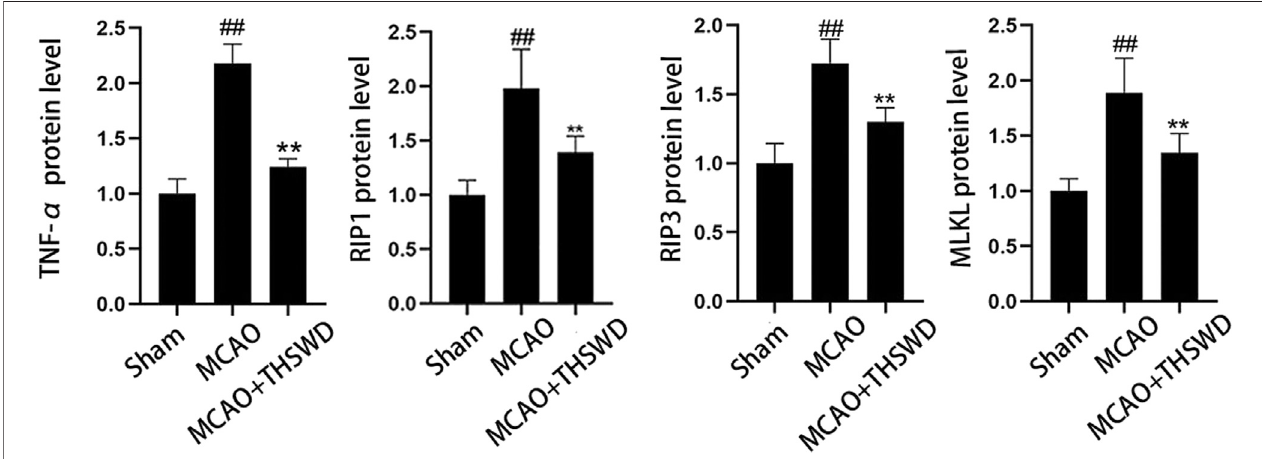
FIGURE 10 | Protein expression of TNF- α /RIP1/RIP3/MLKL Notes: ## P < 0.05 vs Sham operation group; ** P < 0.05 vs MCAO